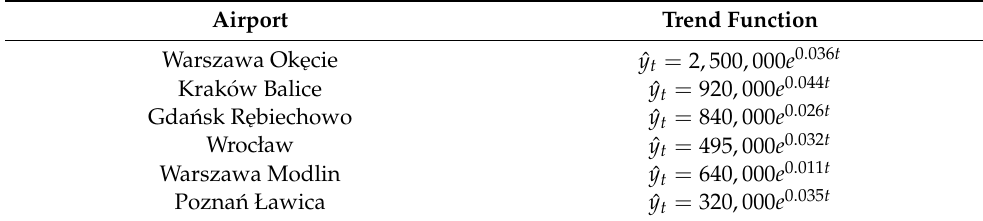
Table 2. Estimated functions of trends.